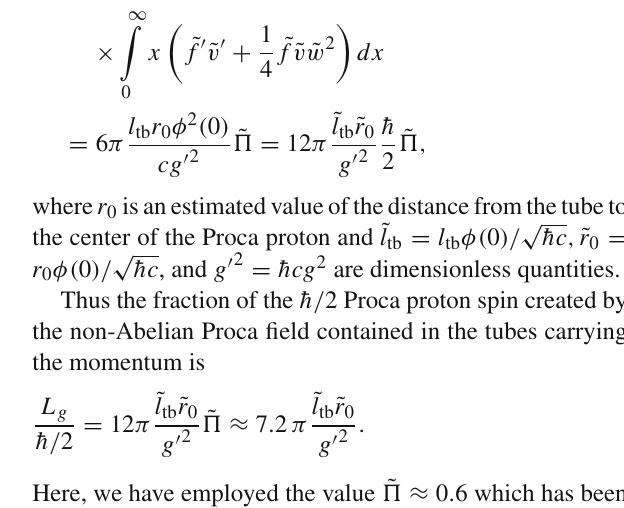
Fig. 9 The schematic sketch of the Proca proton and tubes with the momentum densities whose directions are shown by the arrows